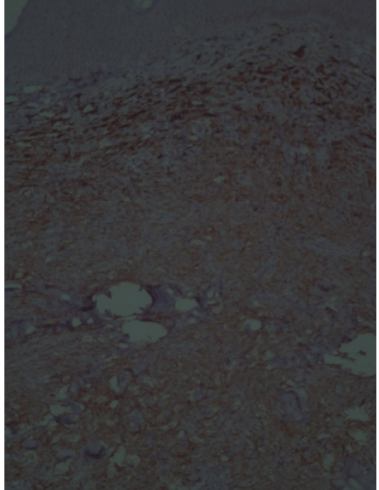
Figure 9: Immunohistochemistry was